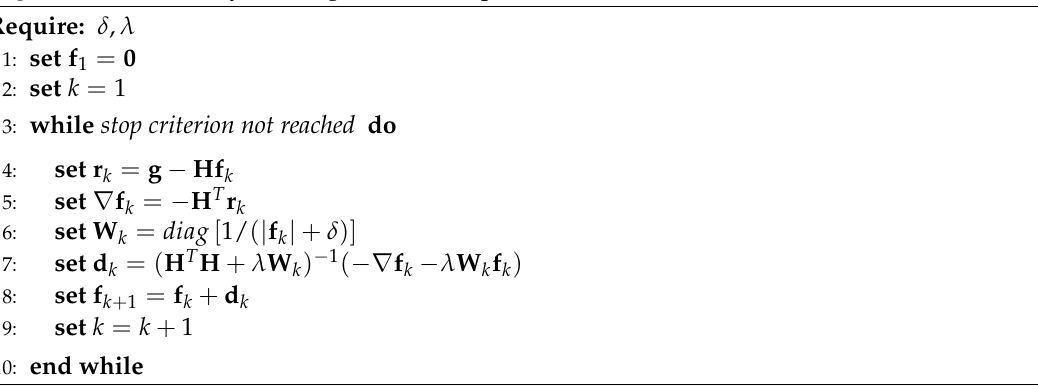
Algorithm 5 Iteratively Re-weighted Least Squares (IRLS)